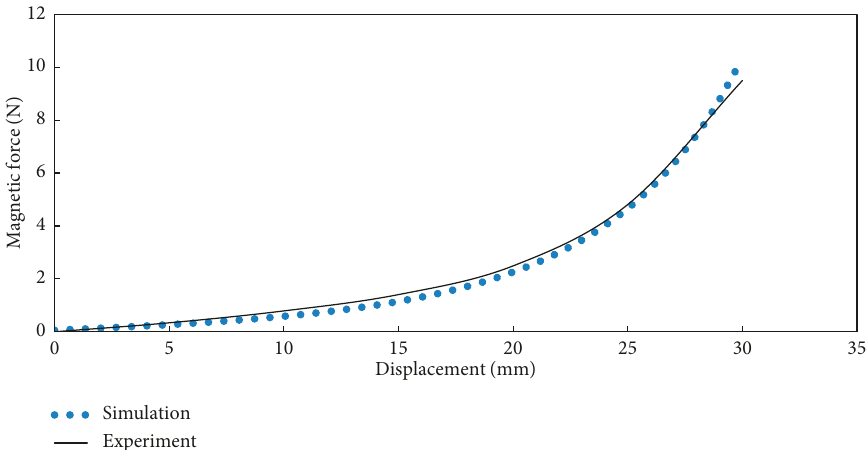
Figure 5: Repulsive force results by the simulating and experimental studies.